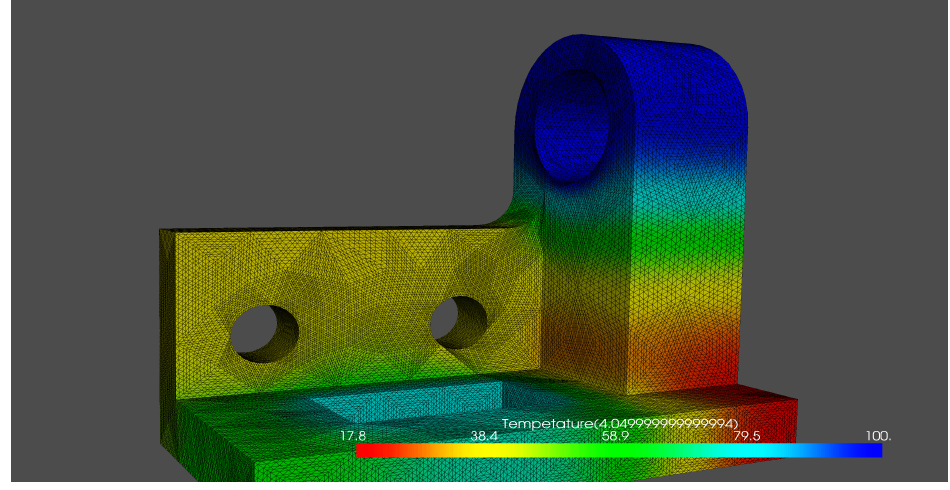
Figure 15. Temperature contour of a function space of order 3 at t = 4.05 s. Table 2. Comparison of execution time between direct and Krylov solvers for TransientThermal.py